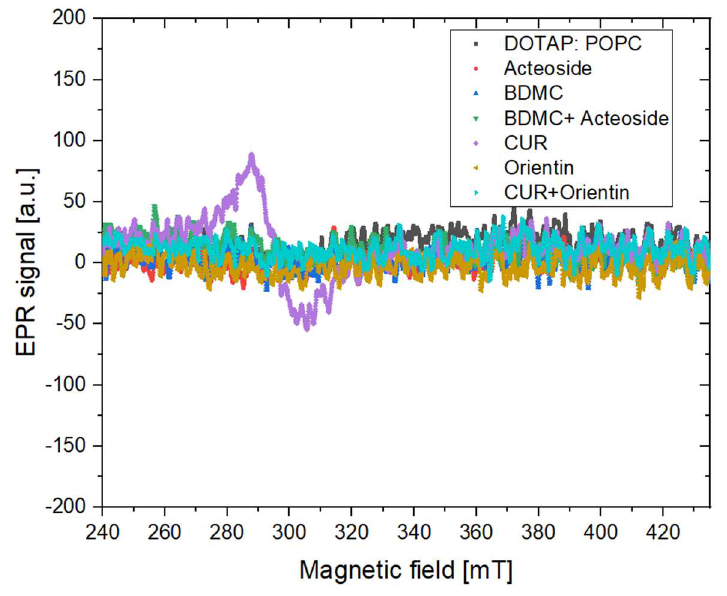
Figure 8. X band measurement results performed to investigate the presence of the stable free radi- cals in the liposome samples; CUR—curcumin, BDMC—bisdemethoxycurcumin. For CUR sample, the EPR line parameters were calculated: line width 17.42 mT, g- factor 2.29, amplitude pp 125